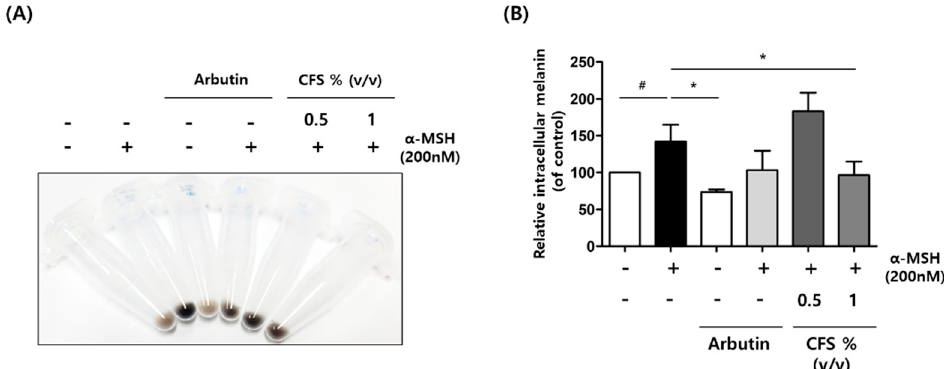
Figure 3. Effect of CFS on melanin production in B16-F10 cells. B16-F10 cells were exposed to 200 nM α -MSH in the presence of 0.5 and 1% ( v / v ) CFS or 200 µM AB. ( A ) Representative images of cell pellets after CFS treatment and ( B ) intracellular melanin contents. The melanin levels were determined as described in the Materials and Methods. CFS: cell-free supernatant from L. gasseri BNR17. Values represent the mean ± SD of three independent experiments. # p < 0.05 compared with control. * p < 0.05 compared with the α -MSH-treated control.